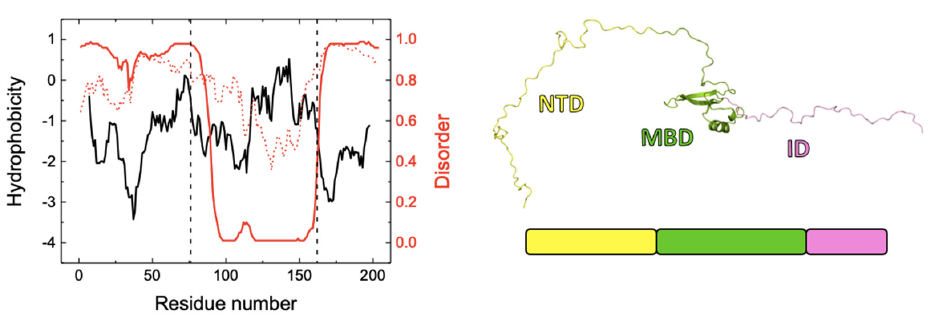
Figure 8. (Left) Hydrophobicity (Kyte & Doolittle scale) plot for NTD-MBD-ID (black) calculated using Expasy ProtScale tool (https://web.expasy.org/protscale/, accessed on 1 July 2021), and disorder prediction plots according to DISOPRED3 (red, continuous line) and IUPRED2 (red, dotted line). The separation between the three domains, NTD, MBD, and ID, are indicated by the vertical dashed lines. (Right) One of the possible conformational states of NTD-MBD-ID, showing the two disordered domains, NTD (yellow) and ID (pink), flanking the folded domain (MBD). The influence of NTD and ID on MBD may be twofold: (1) unspecific, through steric